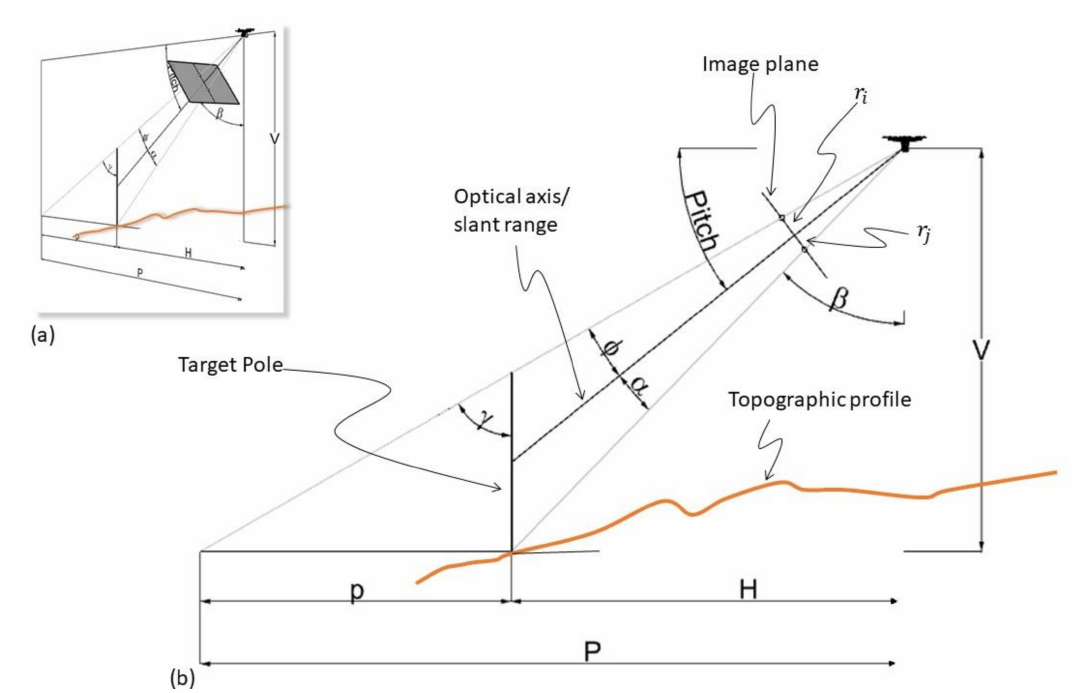
Figure 6. Perspective view of a lightweight UAV pointing to a vertical target (pole) ( a ). Orthogonal view of the same scene with descriptions ( b ) (source: personal